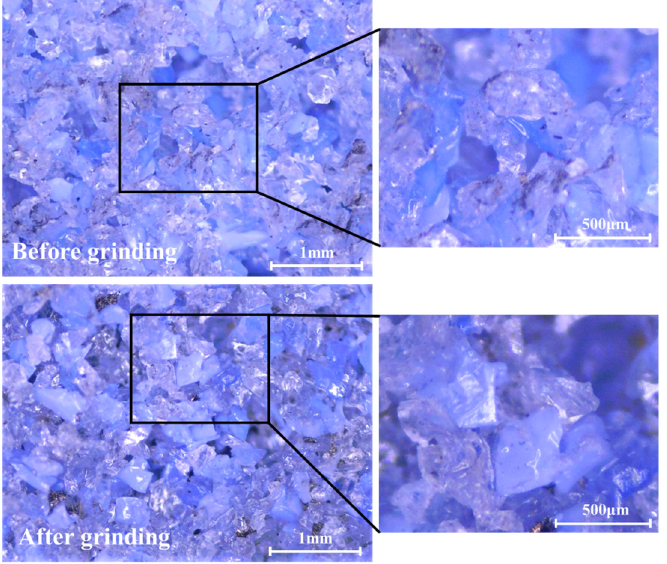
Figure 3. Surface topography of the alumina grinding wheel before and after grinding. Table 2. Details of the process parameters in the gear form-grinding experiments.